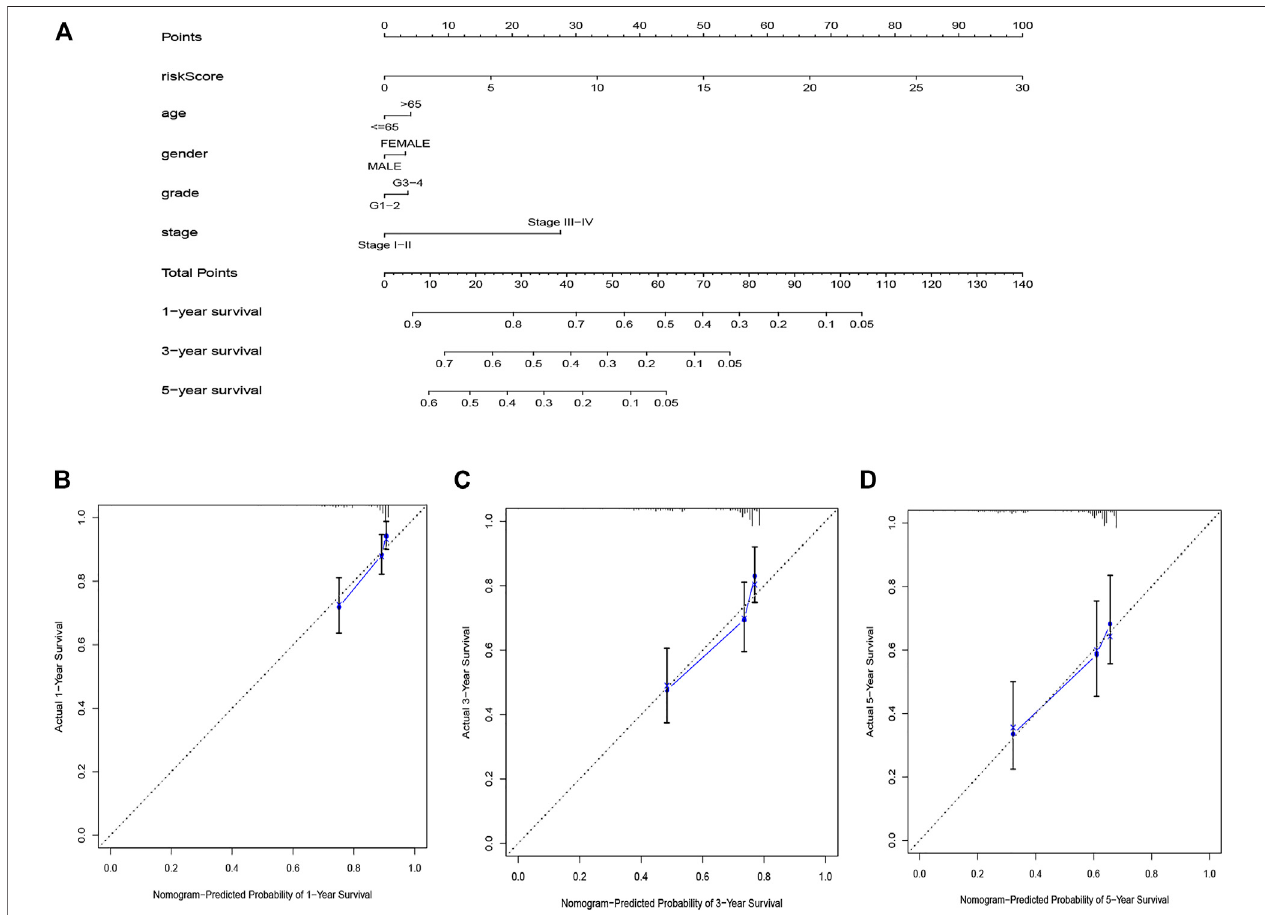
FIGURE 6 | The nomogram for predicting HCC patients ’ survival (A) . Calibration plots applied for predicting the 1-year (B) , 3-year (C) and 5-year (D) survival.